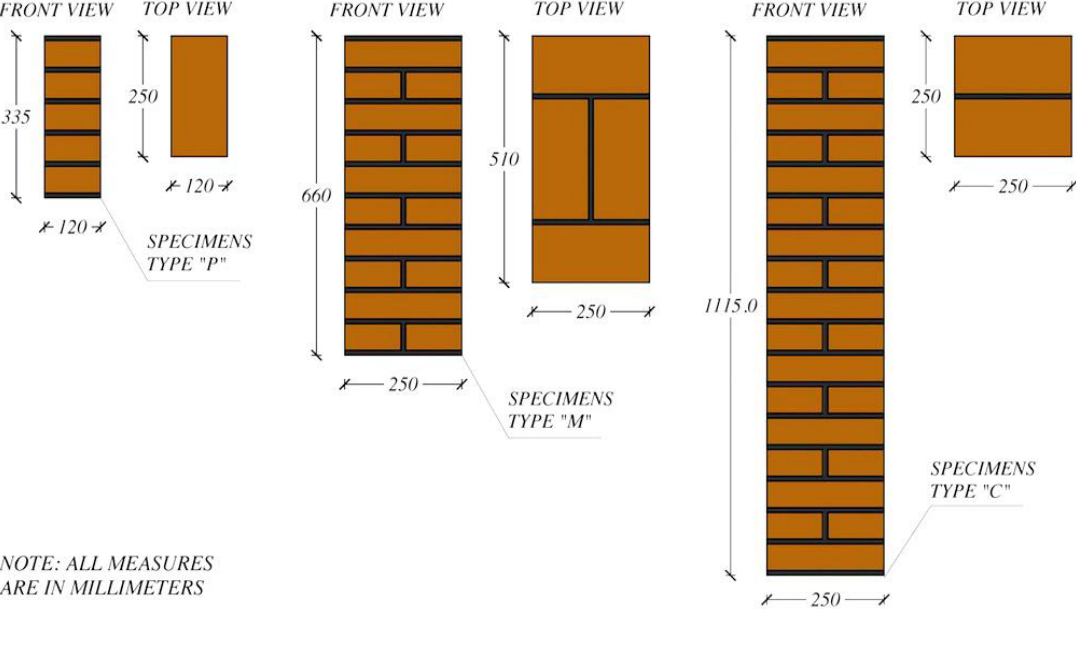
Figure 3. Types of masonry elements.